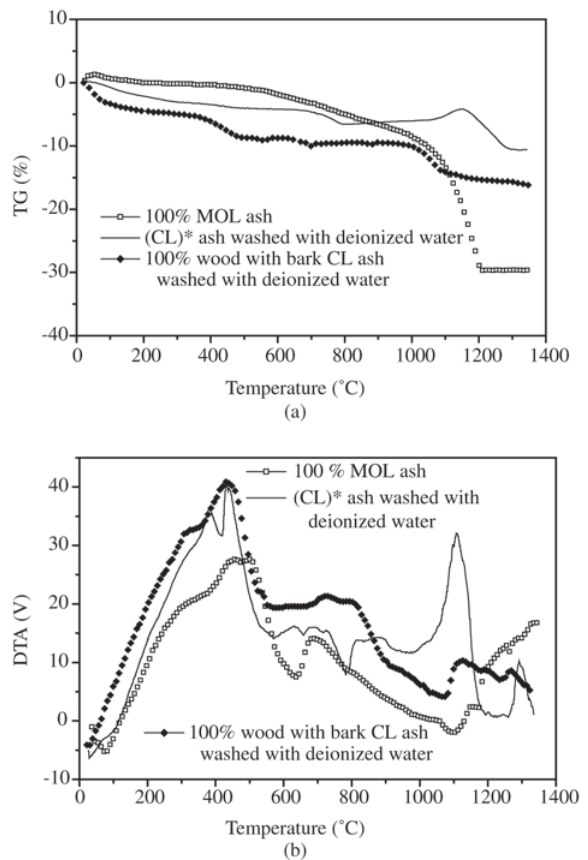
Figure 6. a) Thermo-gravimetric analysis of some ashes; b) Dif- ferential thermal analysis of some ashes.